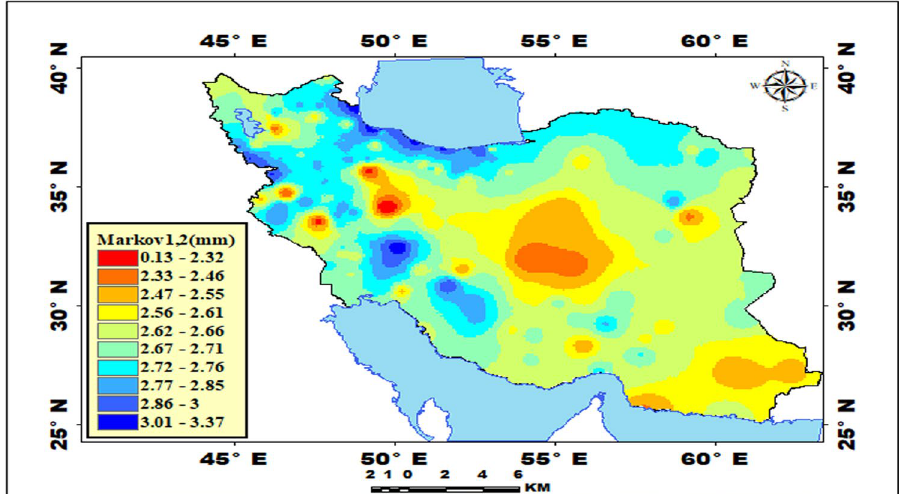
Fig. 5 The predicted data aver- age of daily rainfall based on the two